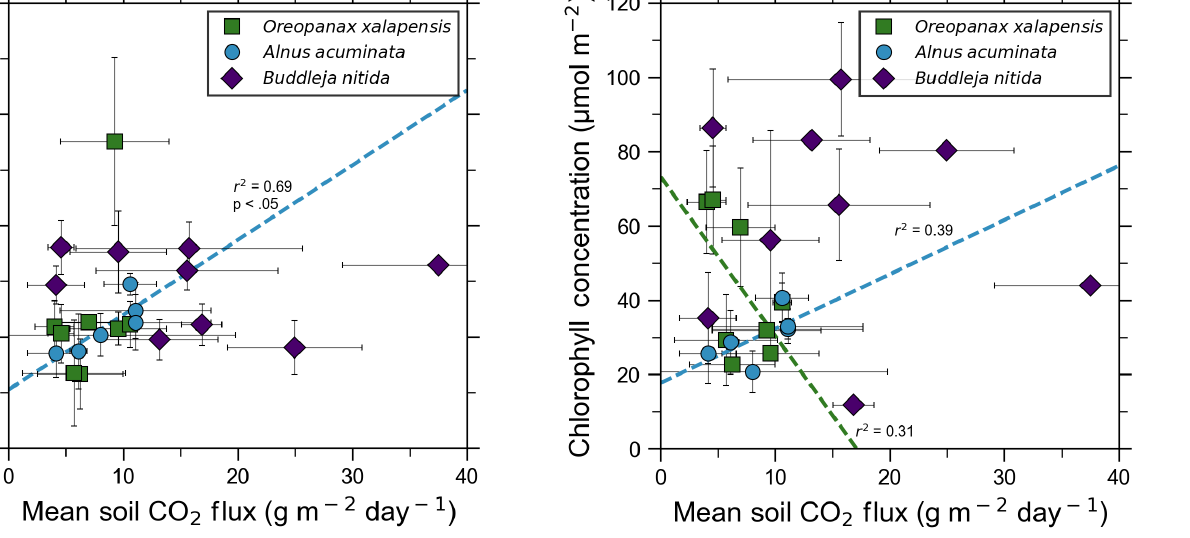
Figure 5. Photosynthetic activity of some tree species in old-growth forests on the upper flanks of two active volcanoes in Costa Rica, Turrialba and Irazú, may show short-term response to volcanically elevated CO 2 . Leaf fluorescence ( F v /F m ) and soil CO 2 flux were strongly correlated for A. acuminata but not for other species.